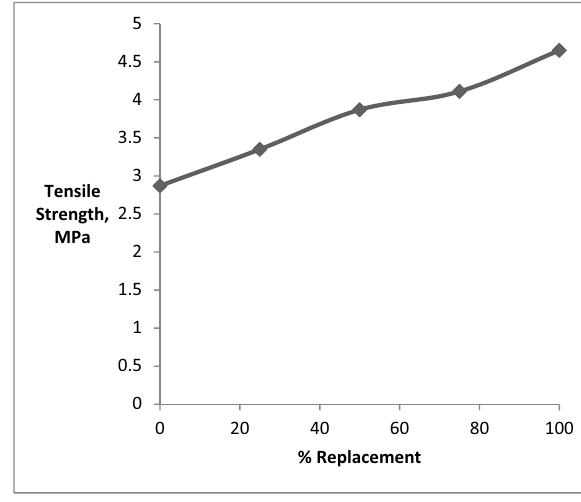
Figure 6: Relation between % replacement and fl exural strength without using